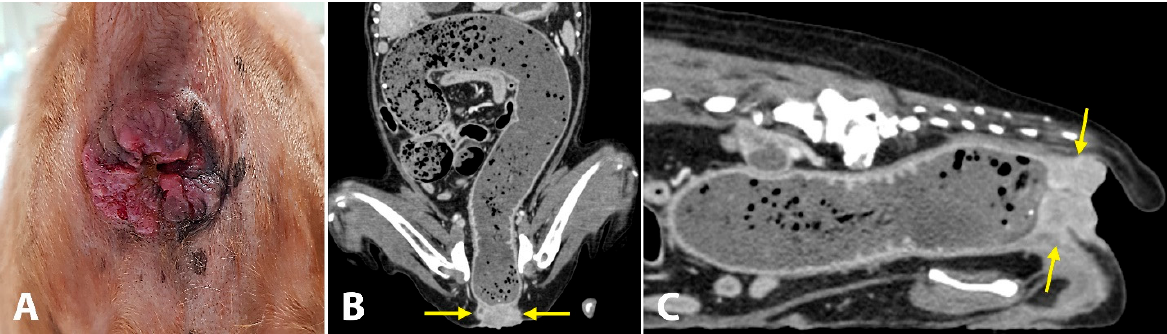
Figure 3. Photograph ( A ) and computed tomography (CT) images ( B , C ) of anal mass in a dog. ( A ) Solid mass with an ulcerative and hyperplastic surface at the anal region. ( B , C ) CT shows an anal mass (yellow arrows), completely blocking the passage of feces. The entire colon is severely dilated.